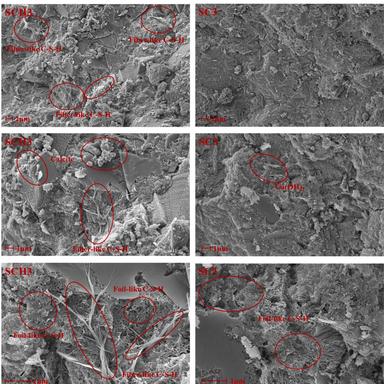
The SEM images of SC3 and SCH3 at 28 days.